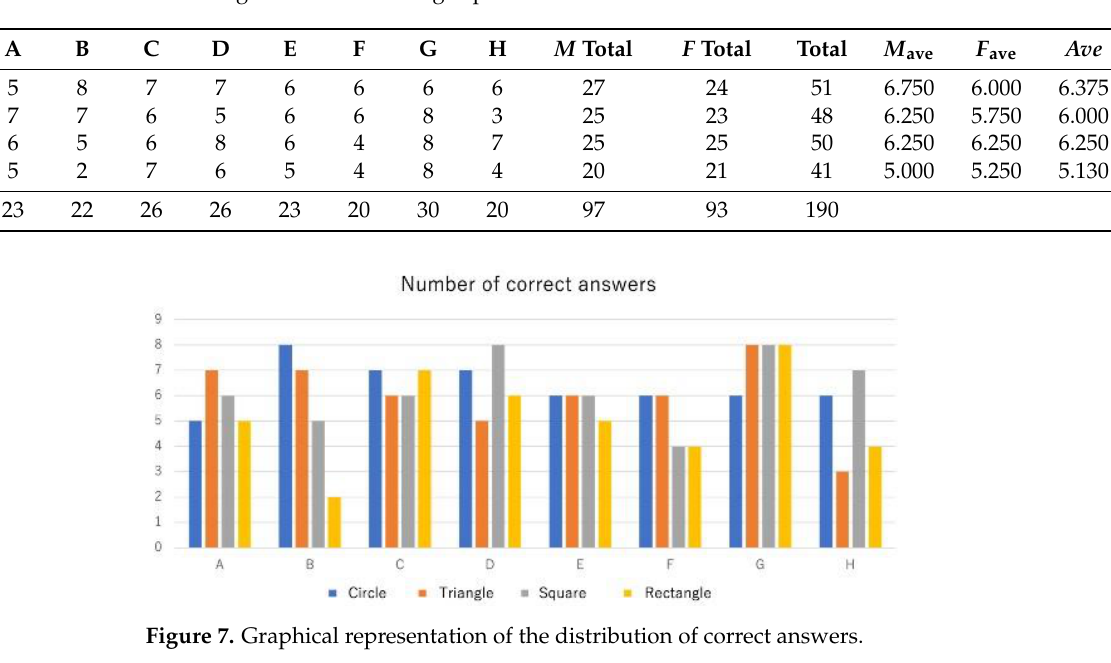
Figure 6. Four shapes were used in the pressure presentation experiments. In each figure, the left